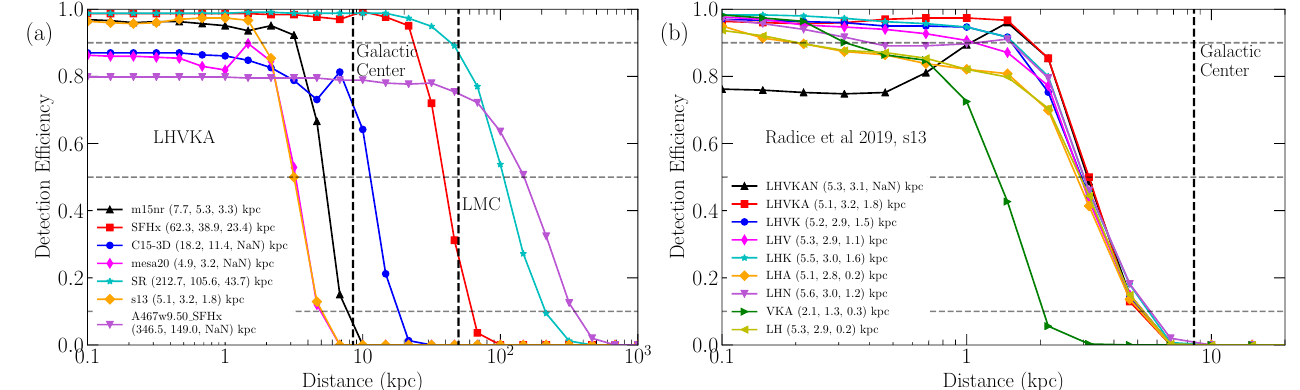
Figure 2. Detection efficiency curves as a function of distance. Numbers in brackets are distances at 10%, 50% and 90% detection efficiency. Plot ( a ) shows how far a CCSN source can be detectable for different models of GW emission [27,29–31,35,39,41] and LHVKA network, and ( b ) different detector networks for the s13 model